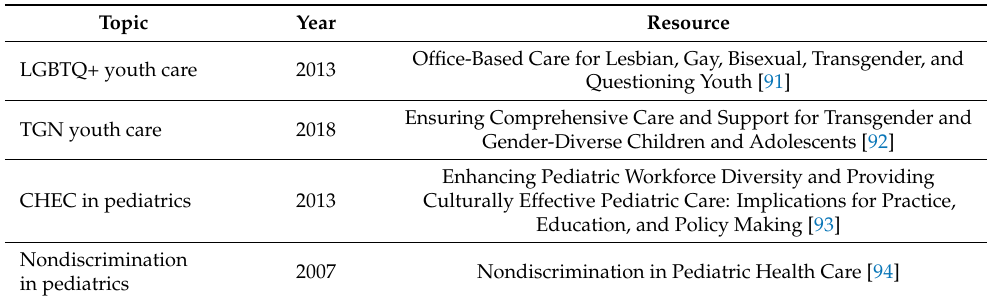
Table 3. Main resources for the care of LGBTQ+ youths. CHEC: Culturally Effective Pediatric Care. Topic Year Resource LGBTQ+ youth